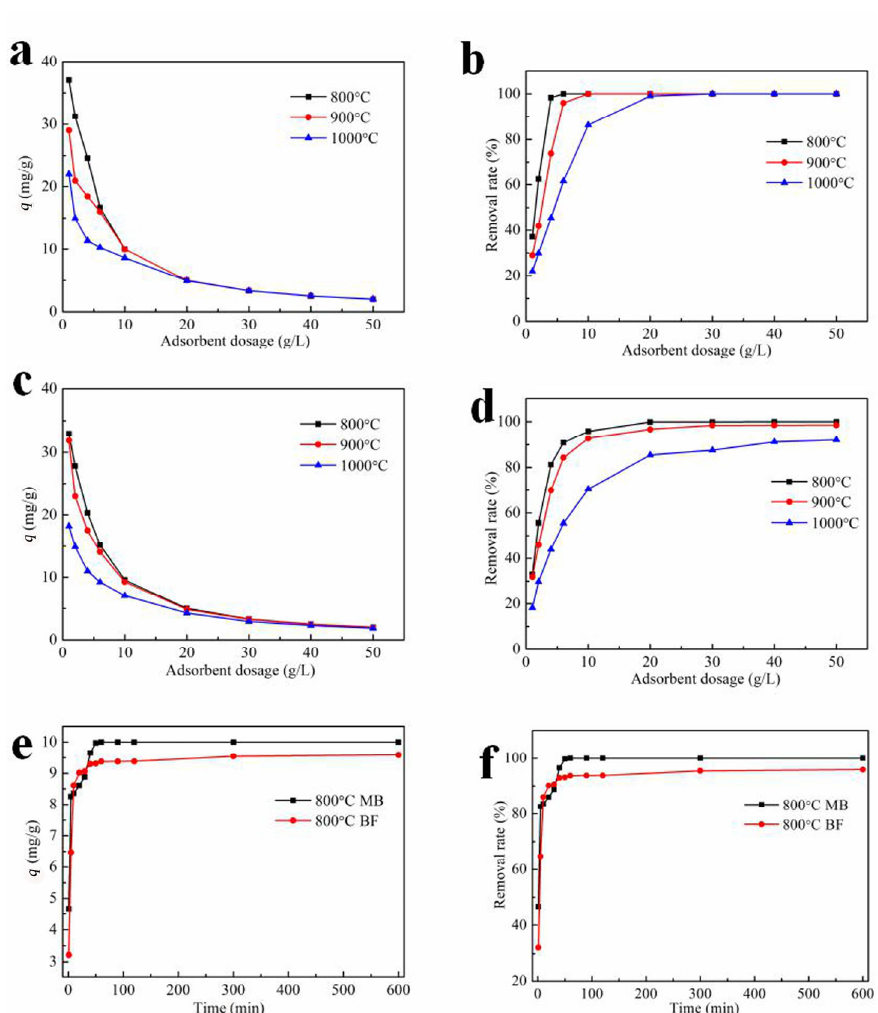
Fig. 10 Effects of operational parameters on the adsorption capacity and removal efficiency of MB and BF: (a, b) MB, (c, d) BF, and (e, f) contact